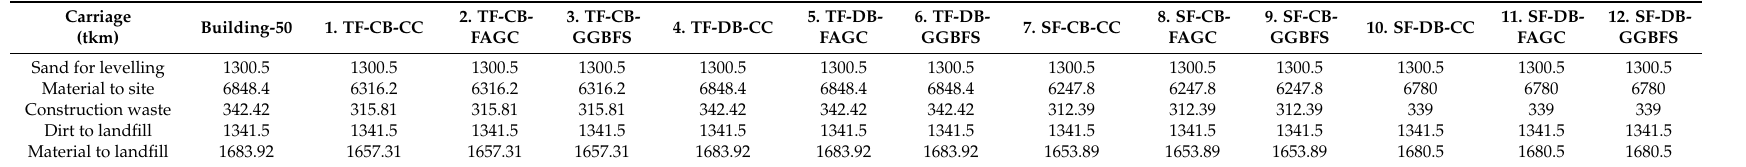
Table A3. Life cycle inventory of material transportation for the construction stage of case study buildings.